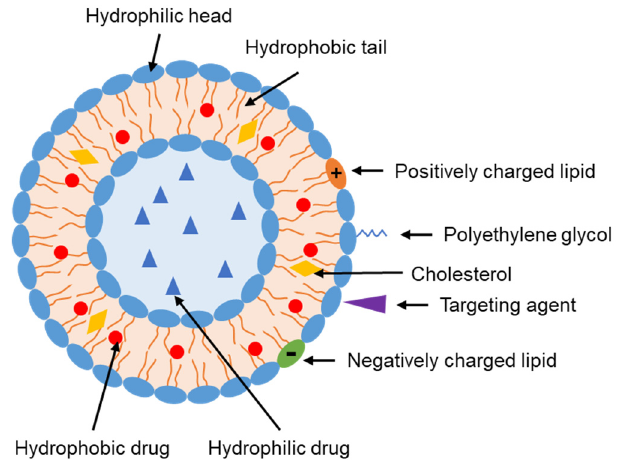
Figure 1. Liposome structure and some modifications. Targeting agents include peptides, proteins, carbohydrates, small molecules, ligands, aptamers, and